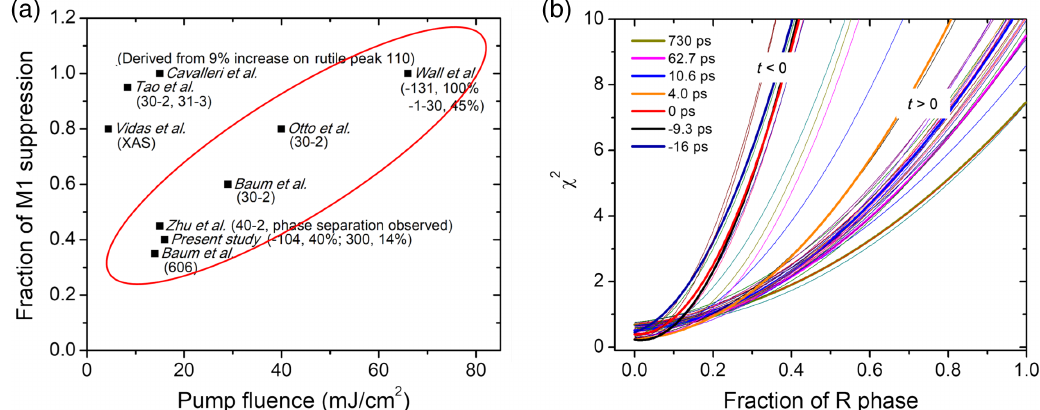
FIG. 5. Exploring the photoinduced volume fraction of the R phase. (a) A comparison of the suppression ratio of the M1 phase reflection intensities after photoexcitation for different pump fluences reported in the literature using ultrafast electrons and x rays. The comparison may not be straightforward as the sample volume and base temperature, which are not included here, might be critical (e.g., data from Ref. [54]). For simplicity, only the most meaningful suppressions are included. For more details, see Table S2 in Supplemental Material [27]. (b) The values of χ 2 derived from Eq. S4 through structure refinement of 20 independent Bragg reflections as a function of the volume fraction of the R phase before and after photon excitation. Data of 42 time delays (thin lines) are included with a few marked by thick lines. The least-squares method was used for the refinement with the parameters such as the displacement along a and c direction and the Debye-Waller